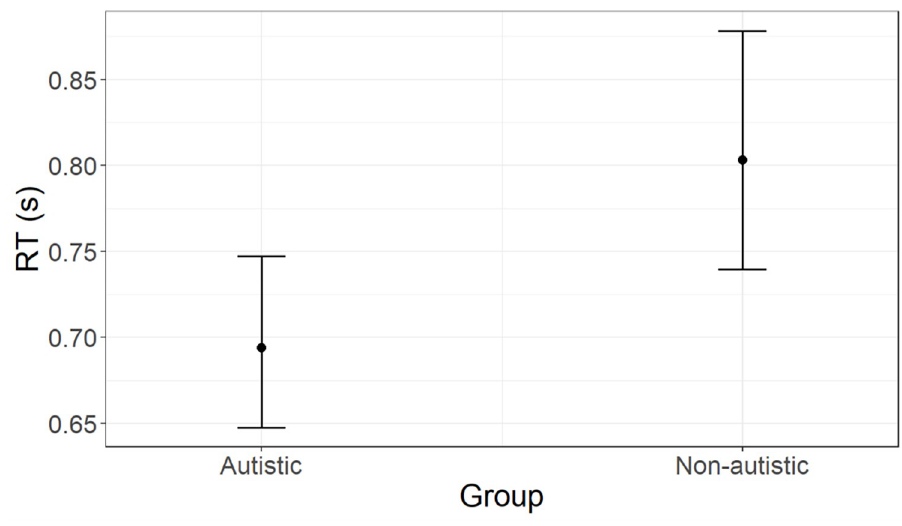
Fig 3. Group effect on RT (agency task), as predicted by m2. Estimated marginal means with whiskers representing 95% confidence